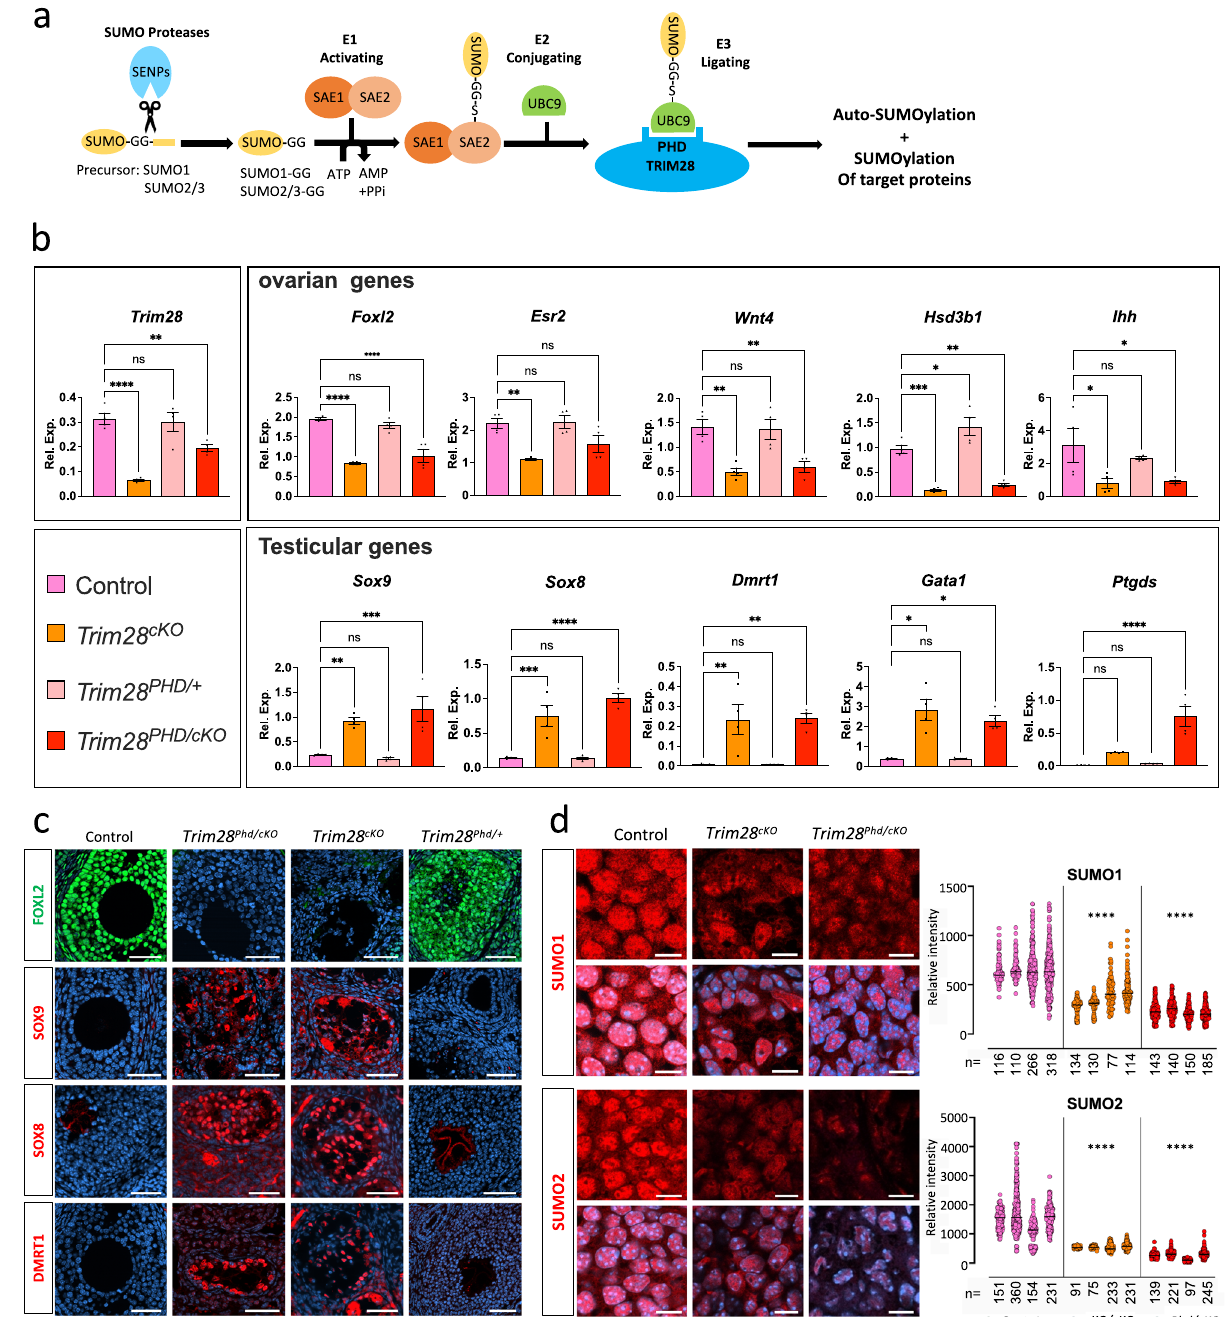
Fig. 4 | Loss ofTRIM28 SUMO-E3-ligase activity in granulosa cellsphenocopies Trim28 conditional knock-out. a Schematic of the SUMO pathway with TRIM28 E3-SUMO ligase activity. After proteolytic maturation by sentrin-speci fi c proteases (SENPs), SUMO C-terminus is activated by the heterodimeric SUMO-activating enzyme E1 (SAE1/SAE2), and then transferred to a cysteine of E2 (UBC9). Subse- quently, the E3 ligases (TRIM28) transfer SUMO from E2 to a lysin residue(s) of target proteins. SUMO2 and 3 diverge by only one residue, making them indis- tinguishable by antibodies, thus they are currently referred to as SUMO2. b RT- qPCR analysis of ovarian- and testicular-speci fi c genes in 8-week-old Trim28 cKO , Trim28 Phd/cKO ,Trim28 Phd/+ ,andcontrolovaries.Barsarethemean±SEM, n =5animals (gonad pairs). P: <0.0001 ( ****) , 0.0002(***) , 0.0021(**) , 0.032(*) (Ordinary one-way ANOVAwithDunnett ’ smultiplecomparisonstest).Detailsofthestatisticalanalysis are provided in the Source data fi le.Source data are provided as a Source Data fi le. c FOXL2isexpressed in controland Trim28 Phd/+ ovaries, but not in Trim28 Phd/cKO and